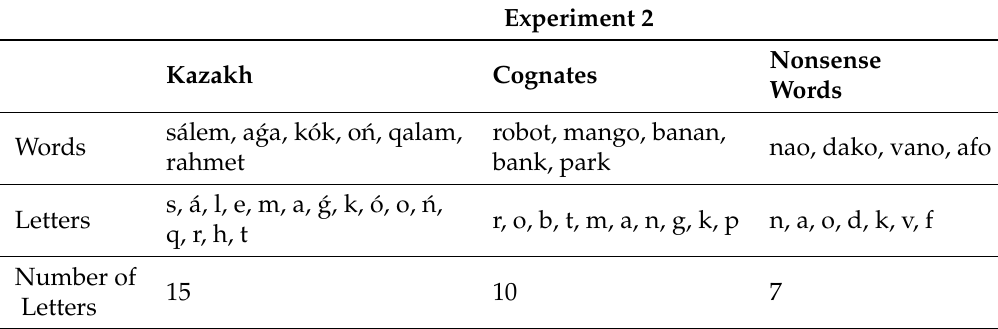
Table 2. Words and letters used in Experiment